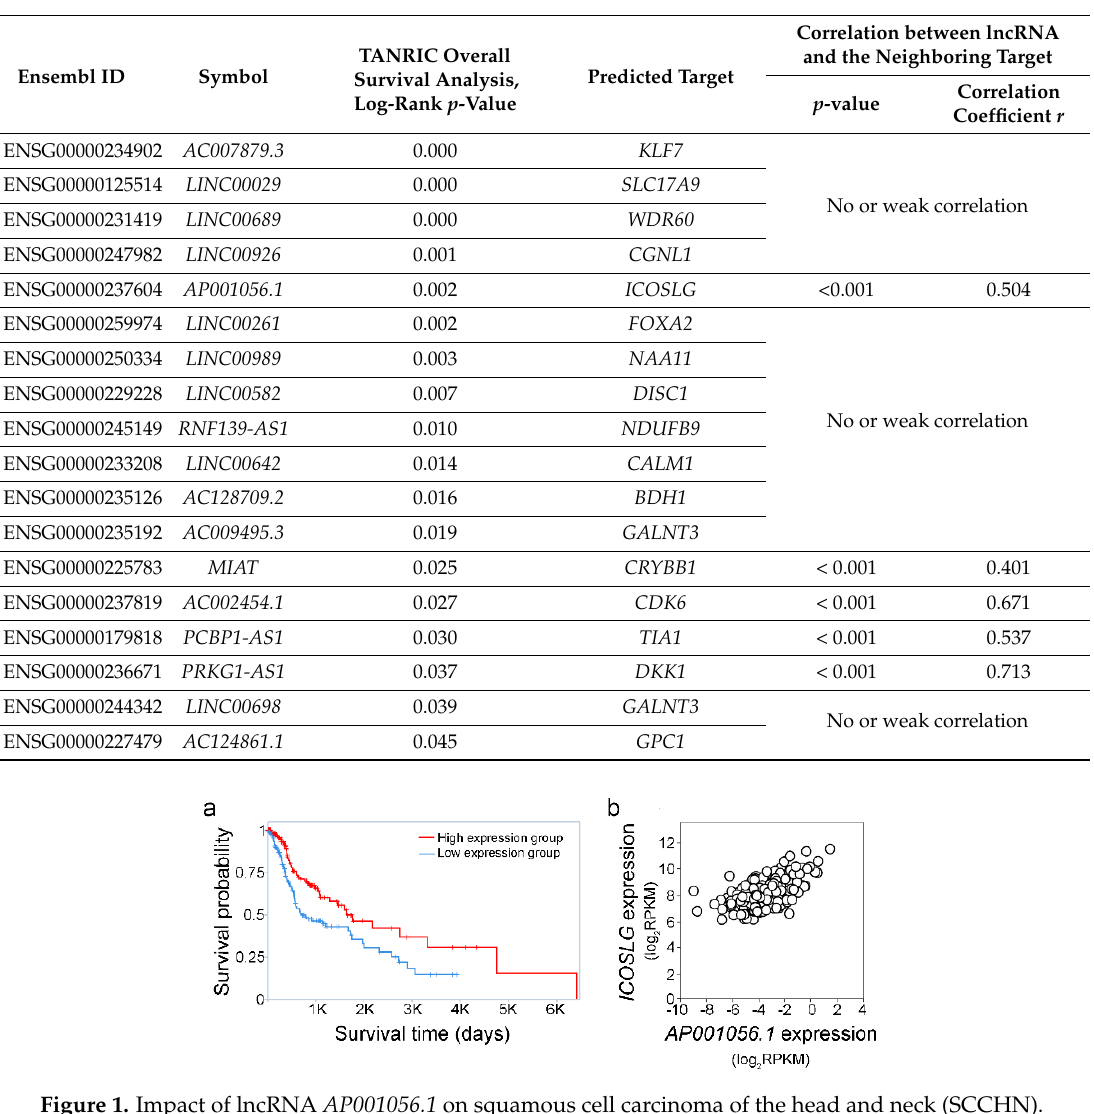
Figure 1. Impact of lncRNA AP001056.1 on squamous cell carcinoma of the head and neck (SCCHN). ( a ) Kaplan–Meier overall survival curve for patients with AP001056.1 -high and AP001056.1 -low expression, obtained through the TANRIC (the Atlas of Noncoding RNAs in Cancer) platform. ( b ) Scatterplot showing the association between AP001056.1 and ICOSLG levels according to TANRIC correlation analysis. Table 2. TANRIC survival analysis and gene expression correlations for AP001056.1 and ICOSLG across 20 cancer types from the Cancer Genome Atlas (TCGA) project.